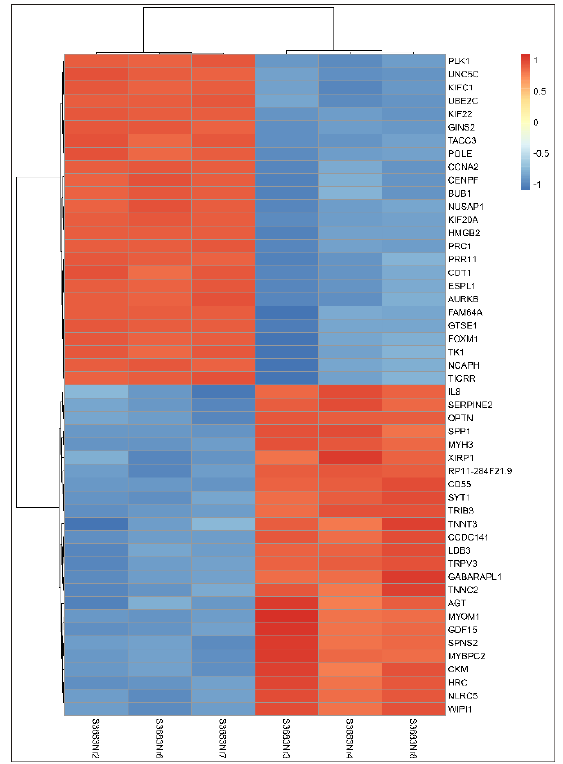
Figure 4. Differential gene expression analysis of RNA-seq results. Heat map showing the 50 most differentially expressed genes (25 upregulated, 25 downregulated) in three control (left side) and three PMA-treated (right side) MO3.13 cells. The columns represent individual samples. To create the heat map, the Z-score of normalized counts was used.